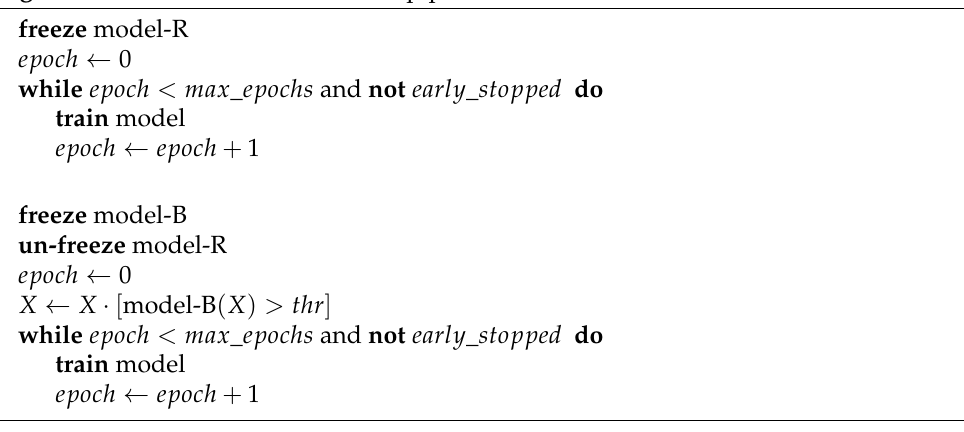
Algorithm 1 Pseudocode for the DFS